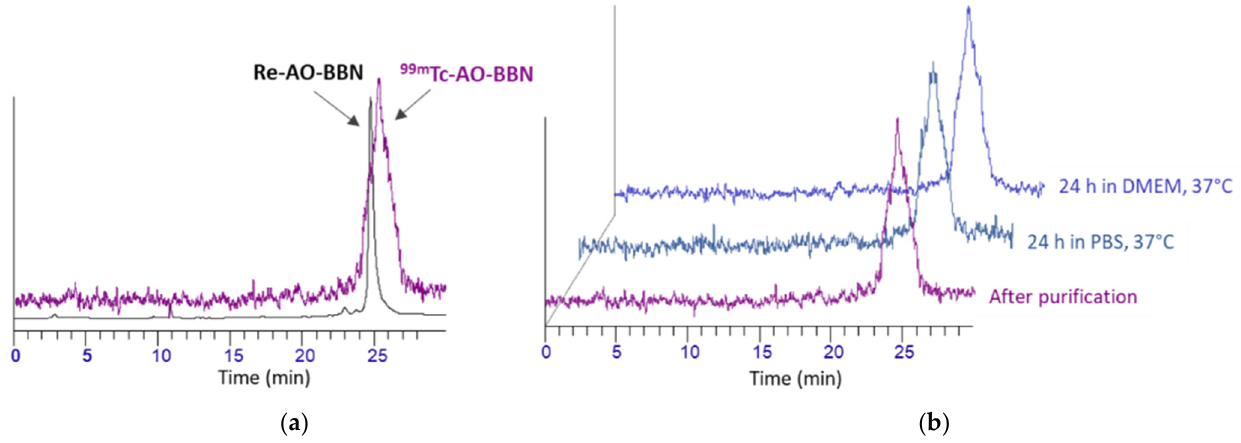
Figure 2. RP-HPLC radiochromatograms ( γ -detection) of 99m Tc-AO-BBN : ( a ) immediately after purification and in comparison with the congener Re-AO-BBN (UV detection); ( b ) after incubation in PBS pH 7.4 and DMEM cell culture at 37 °C for 24 h.